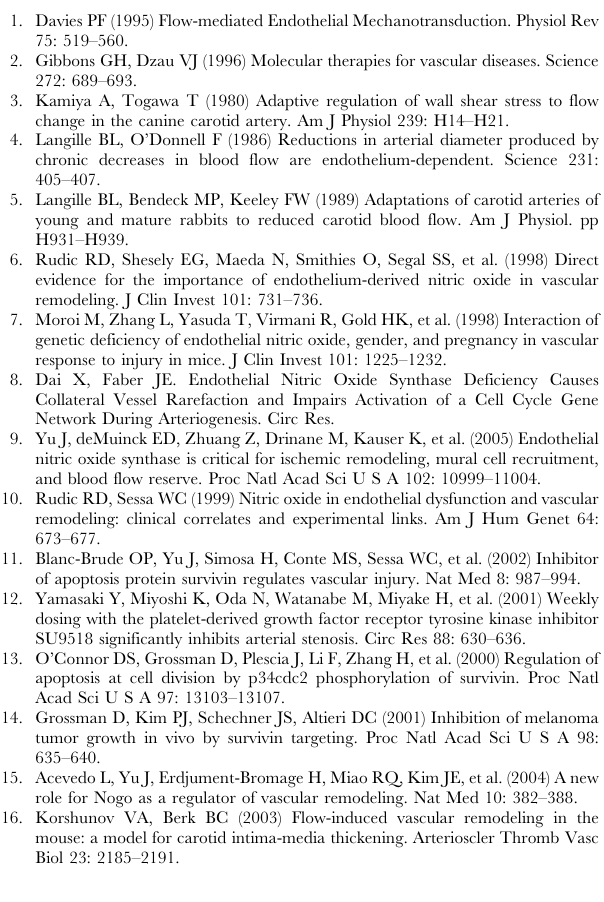
Figure S2 Loss of eNOS does not alter cell apoptosis in response to flow alteration in vivo. (A) Representative images of TUNEL stained remodeled LC from C57Bl/6J and eNOS ( 2 / 2 ) mice 7 days after LEC ligation. TUNEL label in red, SMA staining in green. (B) Quantification of percentage of TUNEL positive cells in total vascular wall cells. N= 3 animal, student T-test was used for statistical analysis.